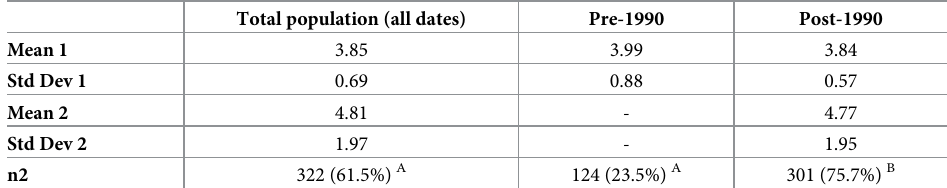
Table 1. Population parameters for CHX susceptibility of Ps . aeruginosa . Total population (all dates)